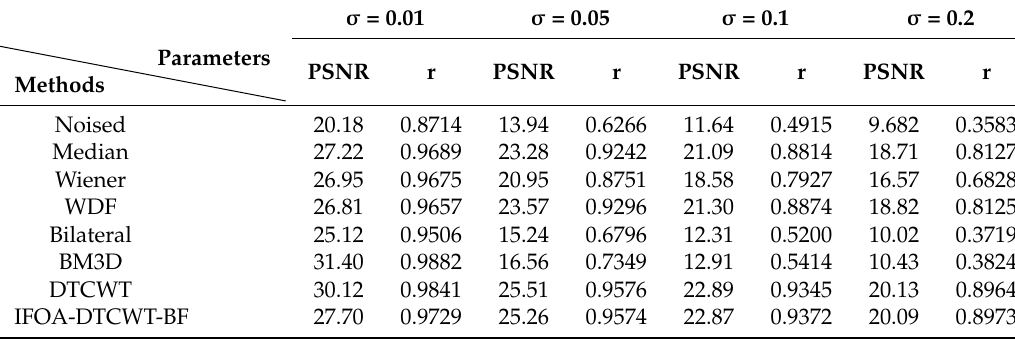
Table 4. Comparison of the five methods (Peppers with Gaussian noise).